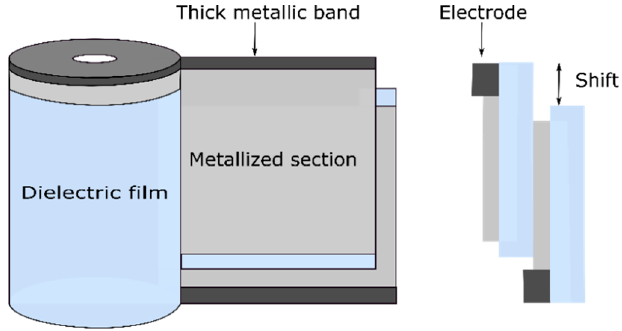
Figure 1. Single-section metallized capacitor.